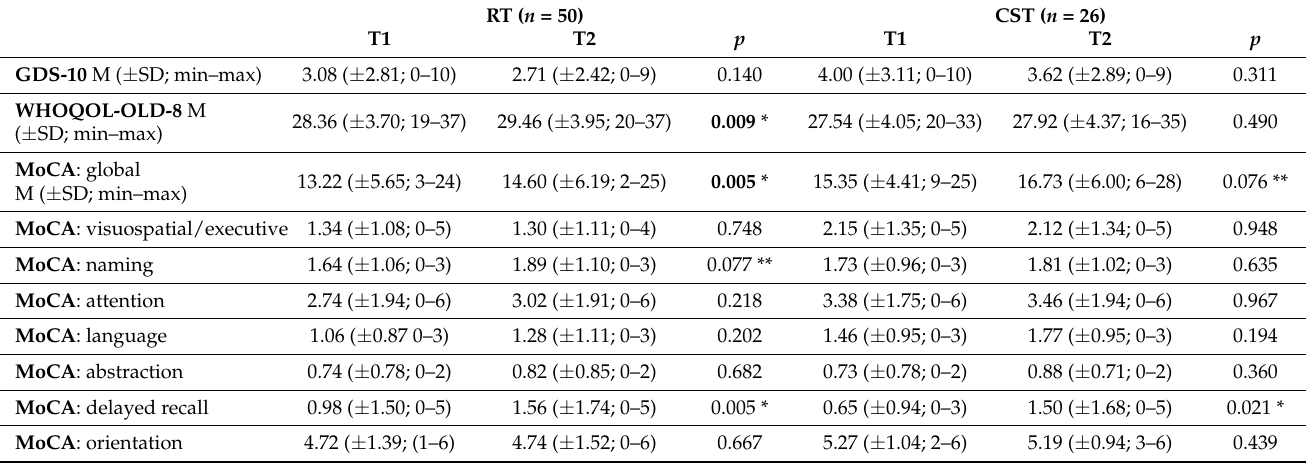
Table 2. Effect of the RT and CST programs in the outcomes of